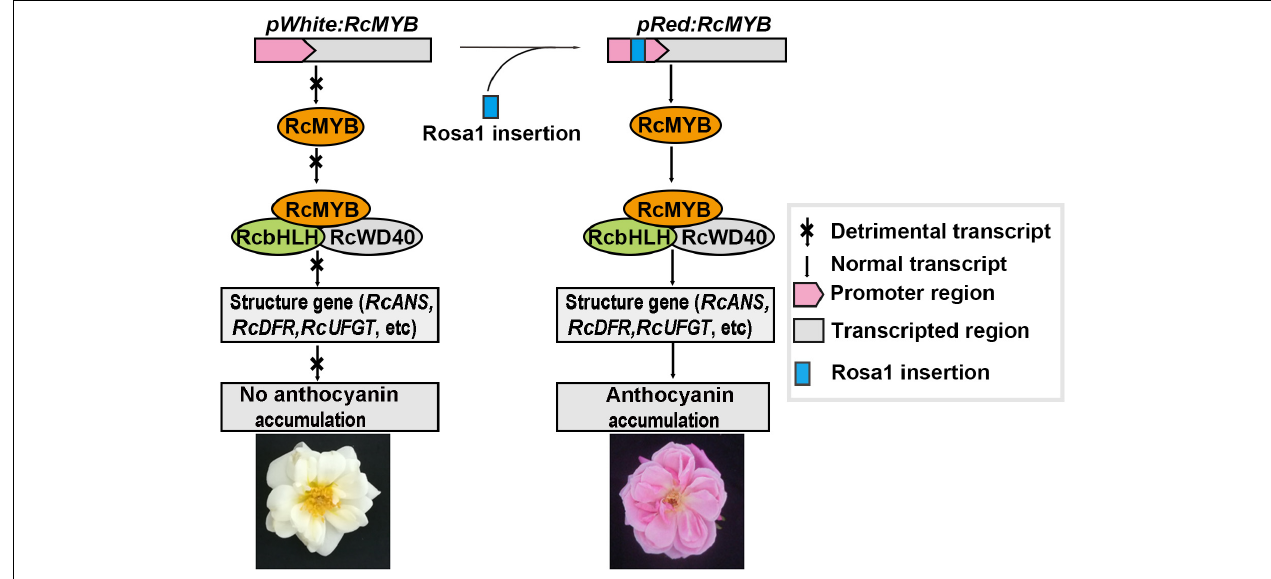
FIGURE 5 | A regulatory model for anthocyanin biosynthesis and accumulation in rose petals.